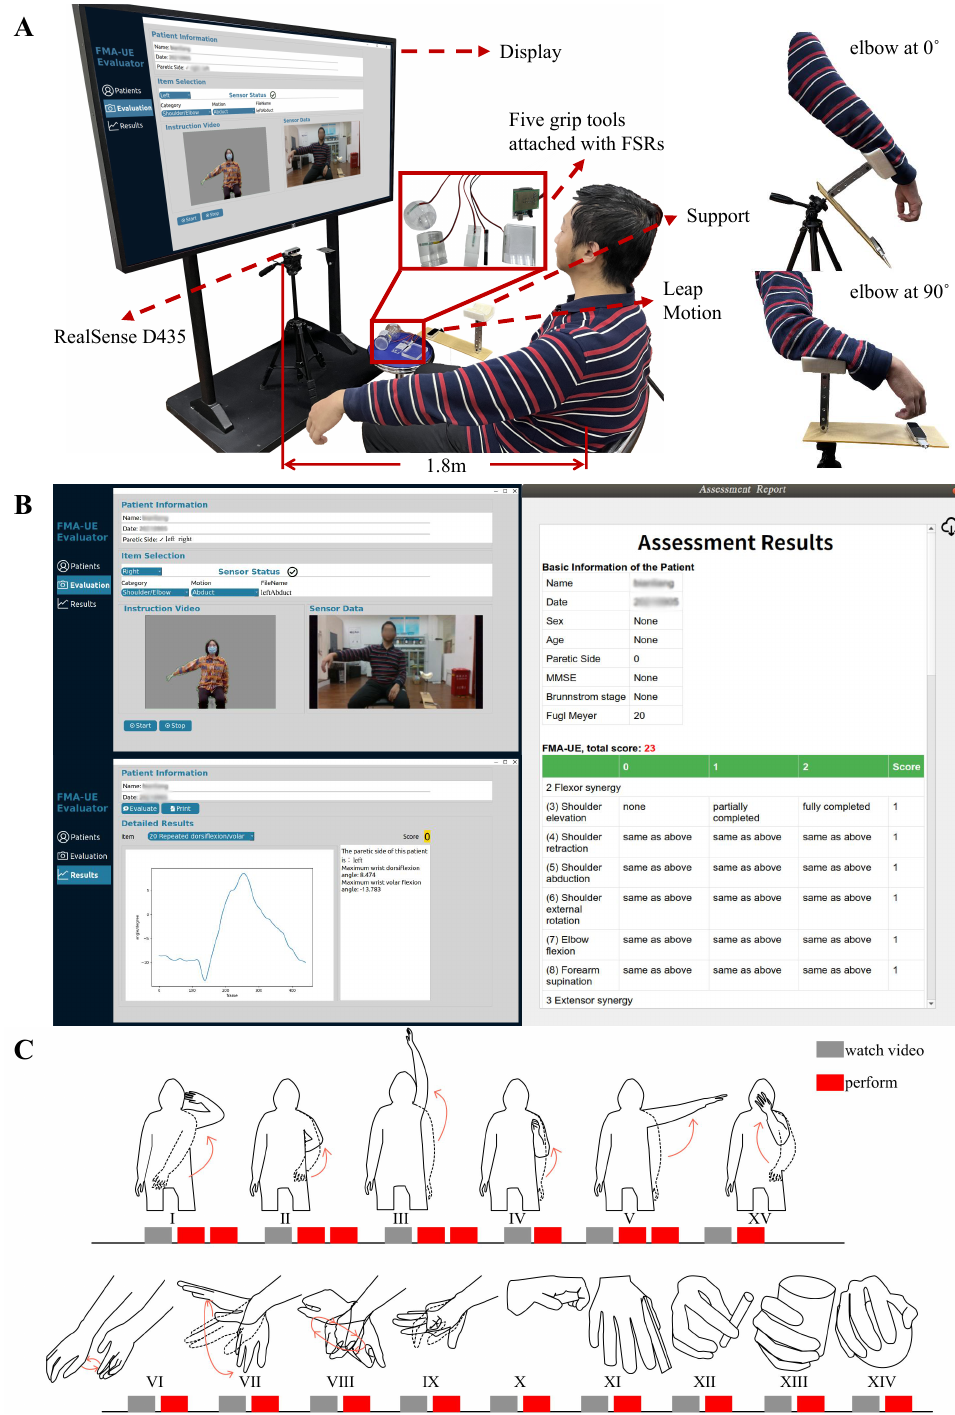
Figure 1. ( A ) The hardware setup and scene of the experiment. On the right are the two initial positions for the Wrist/Hand part. ( B ) The graphical user interface (GUI) of the assessment system. ( C ) The experimental